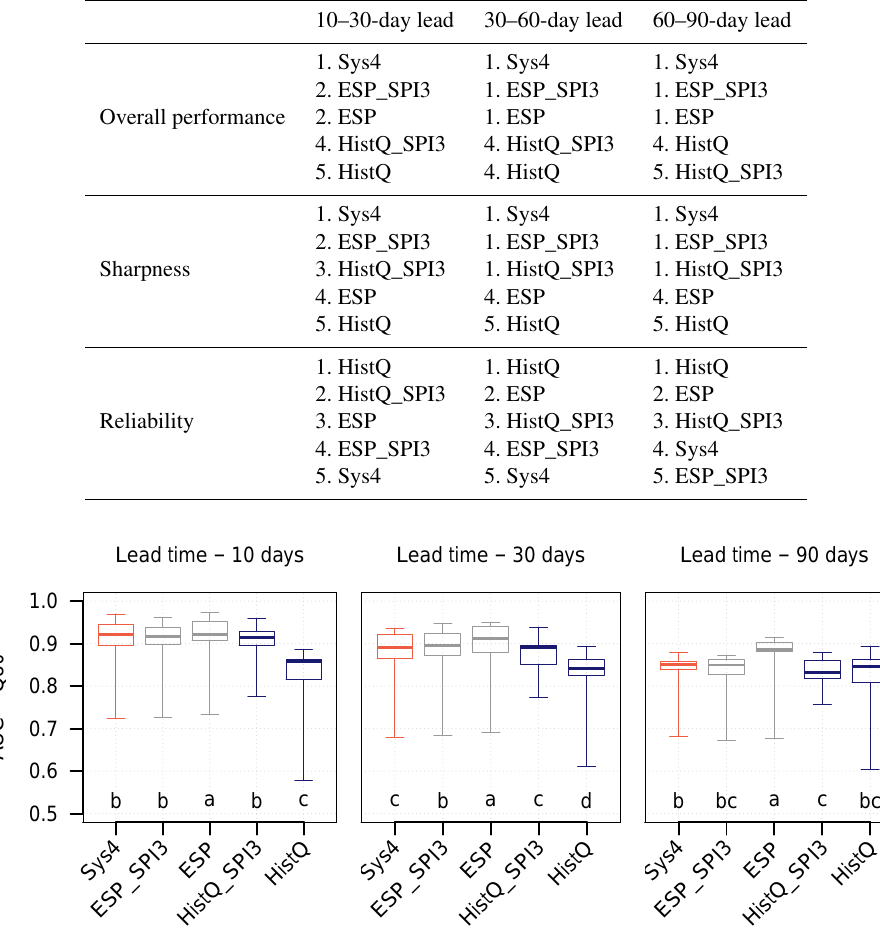
Table 3. Rankings of the Sys4, ESP_SPI3, ESP, HistQ_SPI3 and HistQ streamflow ensembles, as evaluated by three evaluation criteria (in rows) and three lead time ranges (columns). The rankings are based on averaged skill scores for each ensemble, all catchments and for lead times 10 to 30, 31 to 60 and 61 to 90.